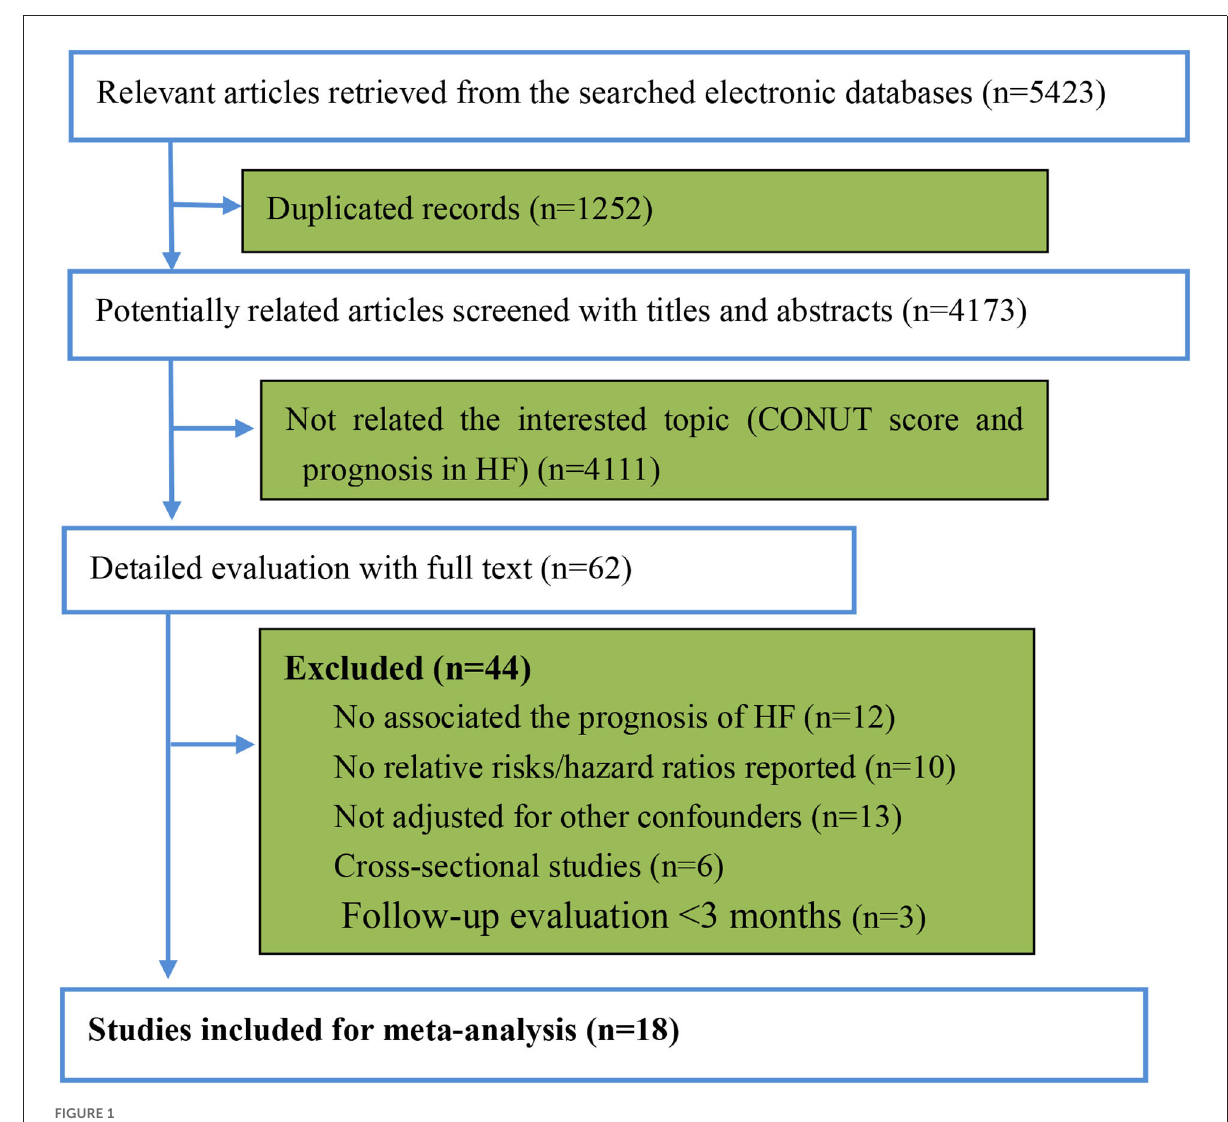
FIGURE1 The review flow of the retrieved studies. CONUT, controlling nutritional status; HF: heart